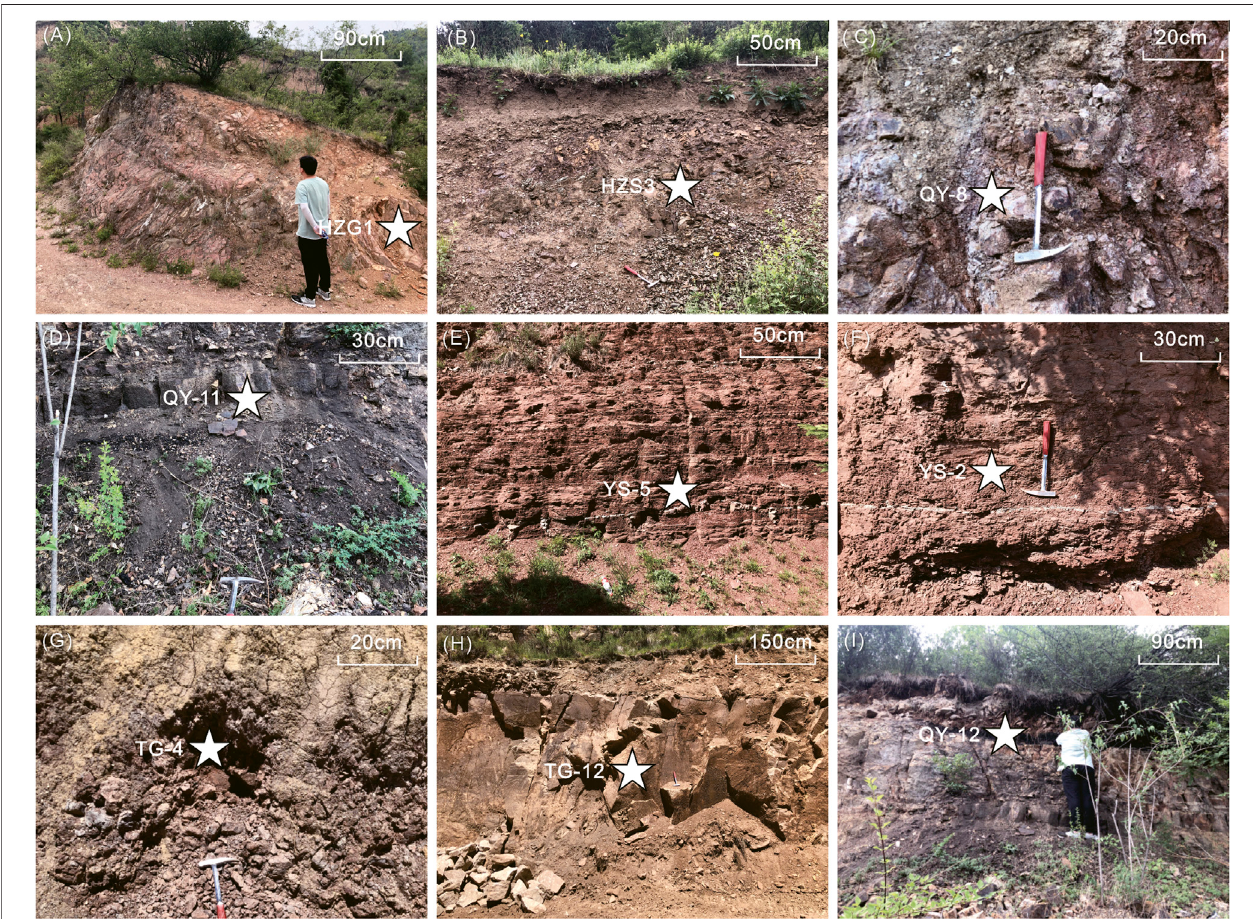
FIGURE 3 | Geological pro fi le of the Qinshui Basin. (A) Dark purple red shale of Guanjiashan, Guanjialiang village, Huozhou (B) Cambrian Mantou formation shale in East Qiliyuvillage,Huozhou (C) MaroonferruginousclaystoneoftheCarboniferousHutiansection,Huozhou (D) GrayblackmudshaleoftheShiheziFormationinDonggou,Qinyuan (E) Purple-redmudstoneintheTriassicHeshanggouformation,Qinyuan (F) SandymudstoneintheTriassicLiujiagouformation,Qinyuan (G) FuchsiamudstoneoftheJurassicRuqu formation, Zijinshan (H) Hujiacun Stage of Yanchang Formation, Zijinshan (I) Gray-black silty mudstone of the Permian Shihezi 1-2 Formation, Qinyuan.